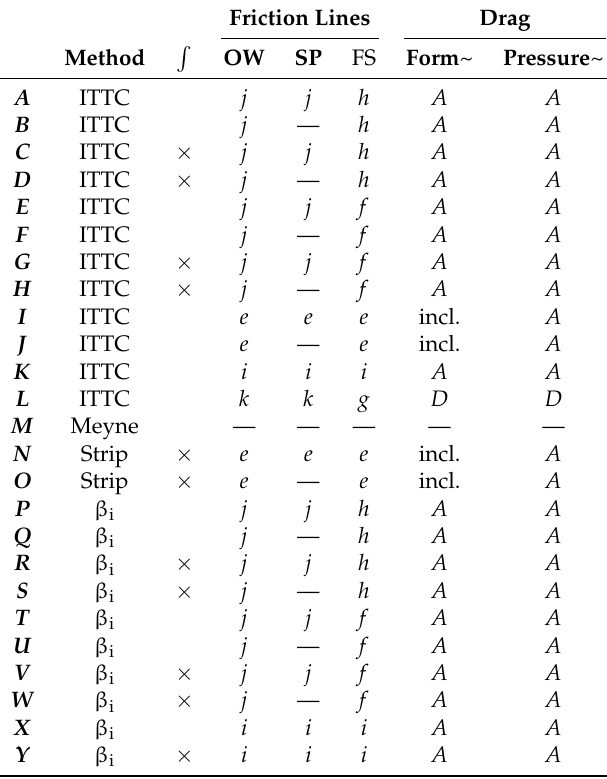
(cid:82) Table 5. Scaling methods λ investigated. A mark in the -columns denotes that the scaling procedure integrates the sectional friction over the whole blade. The capital letters specifying the friction lines, form and pressure drag are references to the Tables 1–4, respectively (OW, open-water; SP, self-propulsion; and FS, full scale). The finished roughness k of the propeller in full scale was assumed to be 20 µ m. Friction